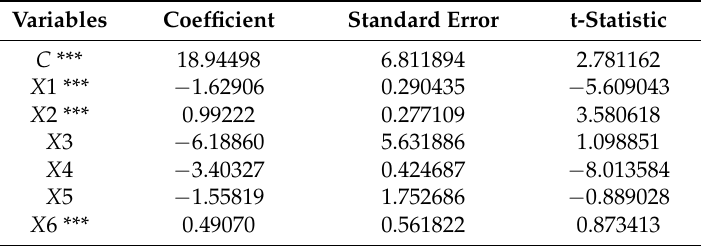
Table 6. Factors’ fixed effect regression results to